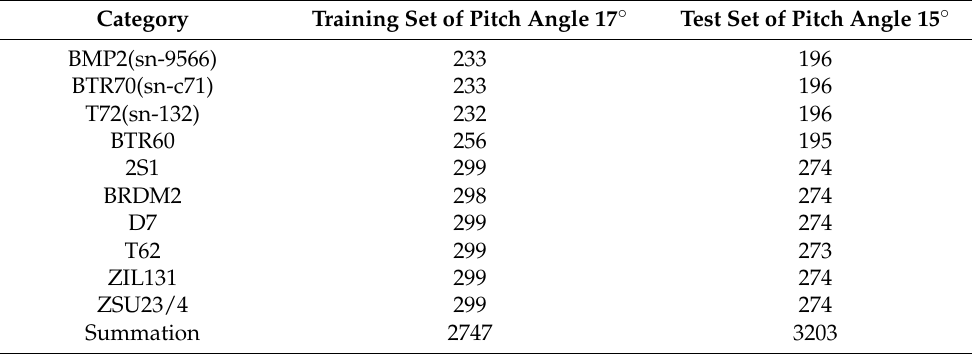
Table 6. Ten types of target recognition problems in MATAR